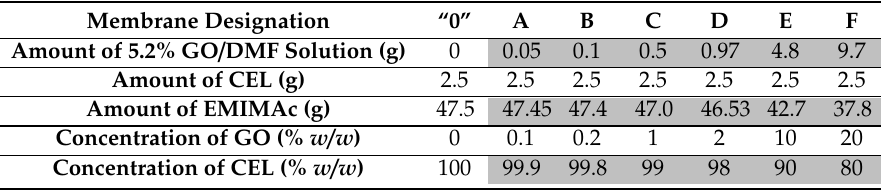
Table 1. The composition of the solutions for the preparation of membranes. CEL: pure cellulose; DMF: N , N -dimethylformamide.